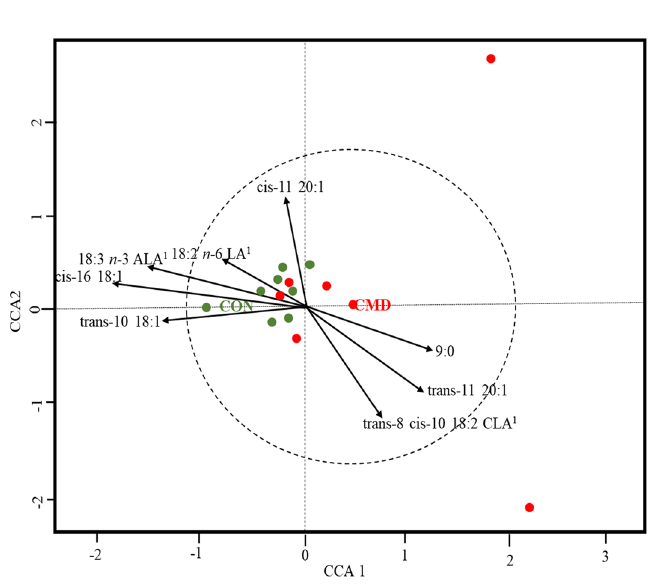
Figure 2. Canonical correspondence analysis (CCA) describing the correlations between the rumen bacterial community structure and the fatty acid profiles in rumen digesta. The arrows indicate the gradient direction, and their length is relative to the proportion of correlation. Arrows longer than the dotted circle signify correlation significance ( P < 0.05). Colored dots represent the distribution pattern of lambs fed the control diet (CON) and cardoon meal diet (CMD). LA linoleic acid, ALA α-linolenic acid, CLA conjugated linoleic